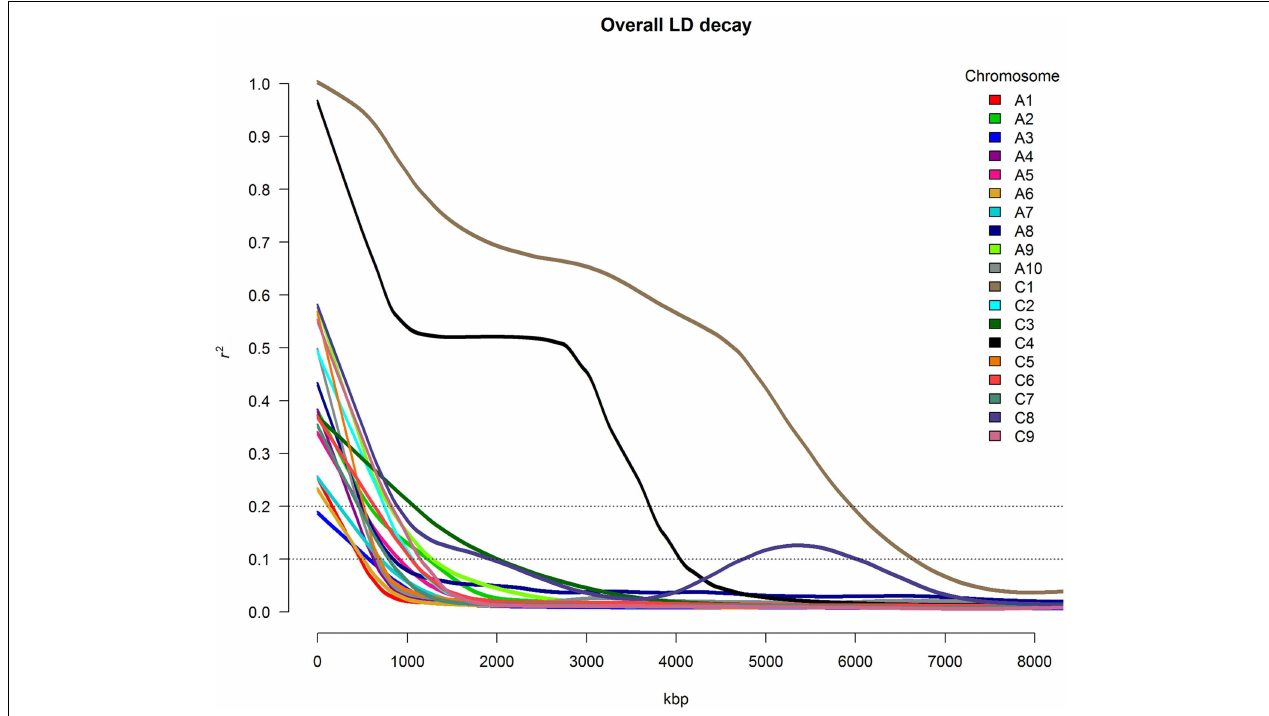
FIGURE 3 | Overall chromosome-wide decay of linkage disequilibrium (LD), shown as smoothed r 2 -values for all marker pairs on each chromosome depending on the distance between marker